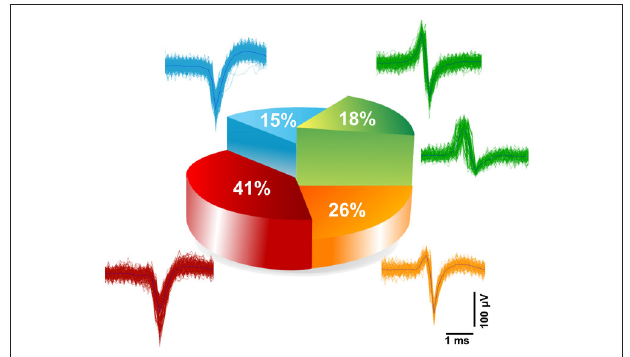
FIGURE 6 | Categorization of extracellular spike waveforms of iCell neuronal recorded. Waveform classifications of evoked responses detected and sorted at 7.8kHz sampling frequency. Two main classes were found; belonging to negative spikes namely (monophasic 41%, biphasic 15%, and triphasic 26%), and positive biphasic spikes